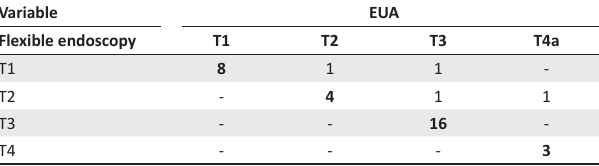
TABLE 2: Staging of laryngopharyngeal tumours with flexible endoscopy against examination under general anaesthesia